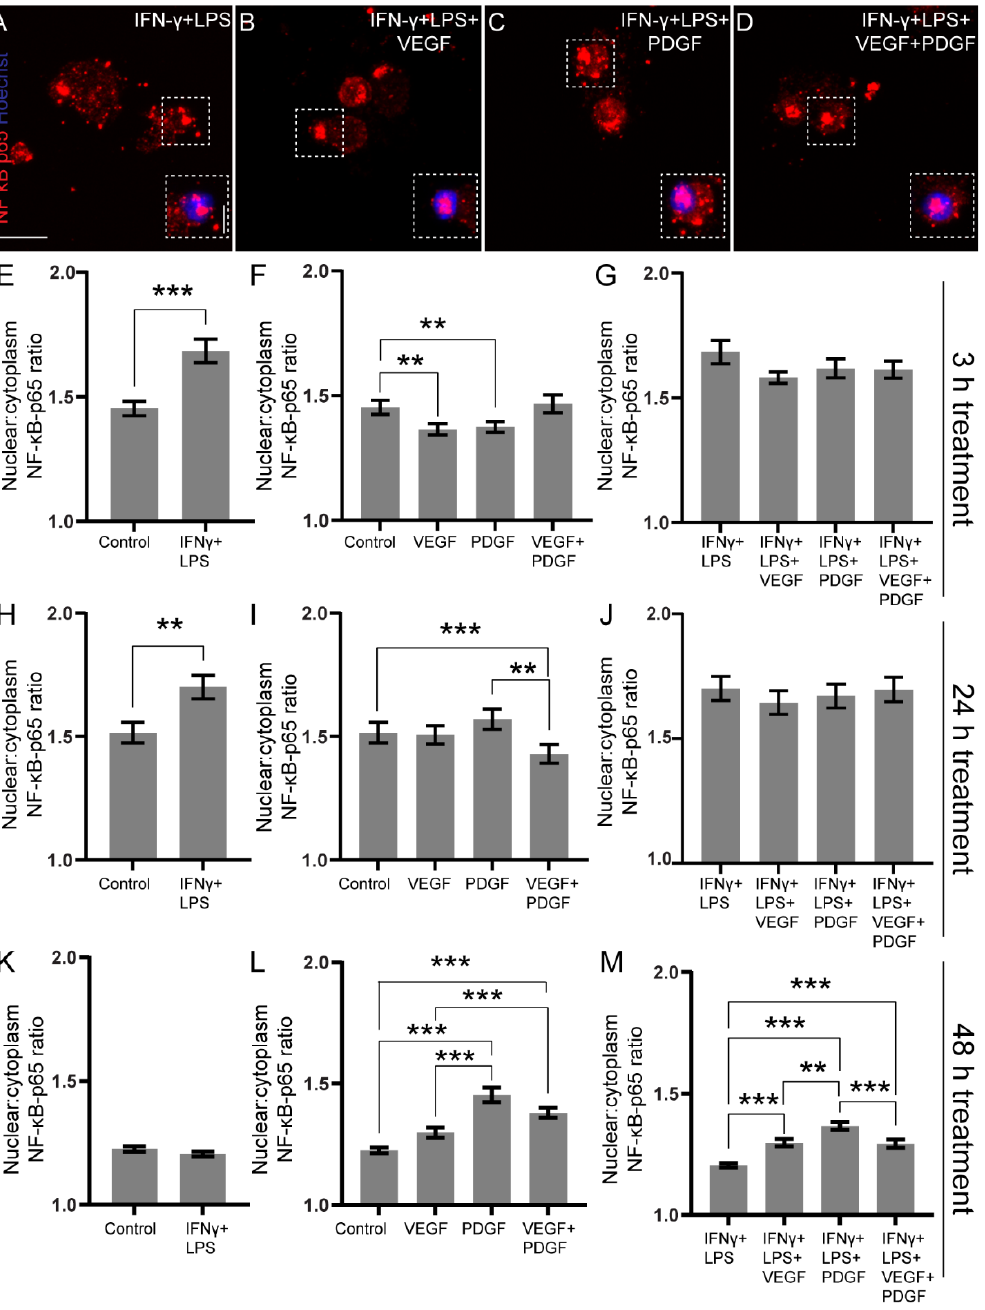
Figure 1. NF- κ B p65 translocation in primary macrophages treated with inflammatory, VEGF, PDGF and combined VEGF + PDGF for 3 h (early), 24 h (middle) and 48 h (late). ( A – D ) Confocal representative images of primary macrophages showing NF- κ B p65 translocation (red) from cyto- plasm to nucleus (blue), treated for 48 h with ( A ): inflammatory media (IFN- γ + LPS), ( B ): IFN- γ + LPS + VEGF, ( C ): IFN- γ + LPS + PDGF, and ( D ) IFN- γ + LPS + VEGF + PDGF. Scale: 15 μ m (5 μ m for inset) across all images. Graphs represent NF- κ B p65 nuclear: cytoplasm intensity ratio (a meas- urement of activation status of macrophage by nuclear translocation) when treated for ( E–G ) 3 h with ( E ) control and IFN- γ + LPS, ( F ) control, VEGF, PDGF and combined VEGF + PDGF, ( G ) VEGF, PDGF and combined VEGF + PDGF in inflammatory media (IFN- γ + LPS); ( H–J ) 24 h with ( H ) con- trol and IFN- γ + LPS, ( I ) control, VEGF, PDGF and combined VEGF + PDGF, ( J ) VEGF, PDGF and combined VEGF + PDGF in inflammatory media (IFN- γ + LPS) and ( K–M ) 48 h with ( K ) control and IFN- γ + LPS, ( L ) control, VEGF, PDGF and combined VEGF + PDGF, ( M ) VEGF, PDGF and com- bined VEGF + PDGF in inflammatory media (IFN- γ + LPS). ** p ≤ 0.01, *** p ≤ 0.001 measured using